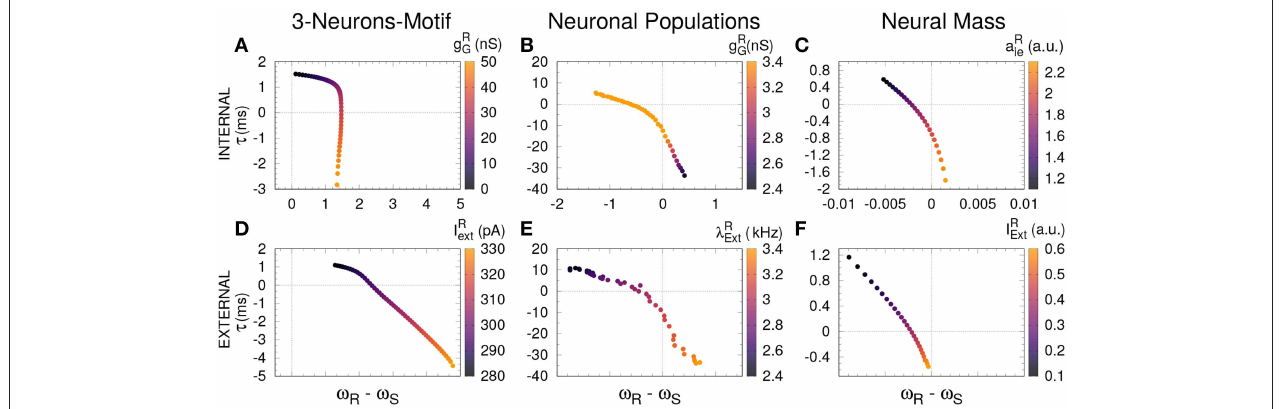
FIGURE 4 | Delayed and anticipated synchronization as a function of the free-running frequency. For all the cases, τ (y-axis) was computed in a coupled system, while the frequency difference (x-axis) was computed for an uncoupled system; the parameters used in both cases are specified by the color code. (A–C) Internal parameter vs. frequency differences and (D–F) external parameter vs. frequency differences, for 3-neurons-motif, neuronal populations, and neural masses, respectively. Horizontal and vertical dashed lines represent zero − lag synchronization (coupled system) and a perfect match between sender and receiver free-running frequencies, respectively. For the parameters used here see